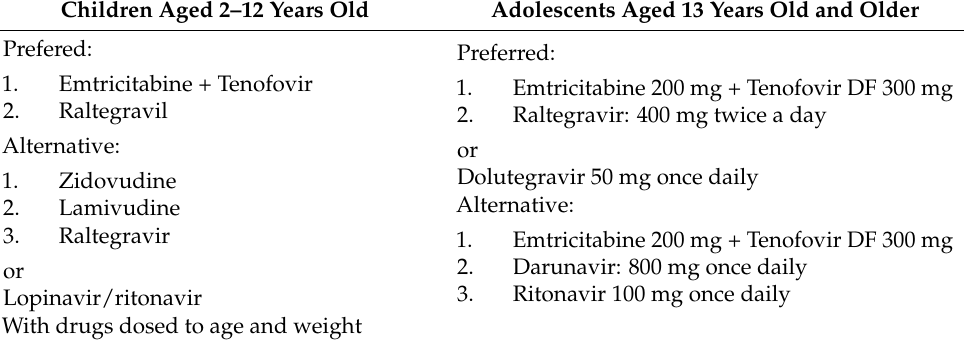
Table 7. Postexposure prophylaxis—ARV drug regimens for pediatric patients according to CDC guidelines